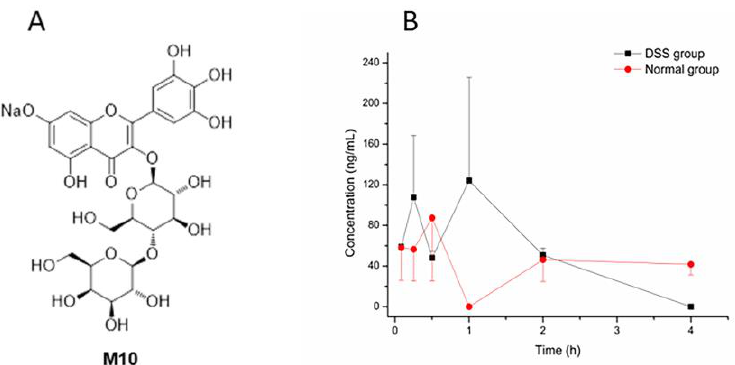
Figure 1. The structure of M10 and the concentration–time curve of M10. ( A ) The structure of M10. ( B ) The concentration–time curve of M10 in DSS-group mice and normal-group mice after oral administration of M10 (50 mg/kg) in plasma. Data are expressed as mean ± SD (n = 3). Plasma samples were collected at 5 min, 15 min, 30 min, 1 h, 2 h, 4 h, 6 h and 8 h after the dose.